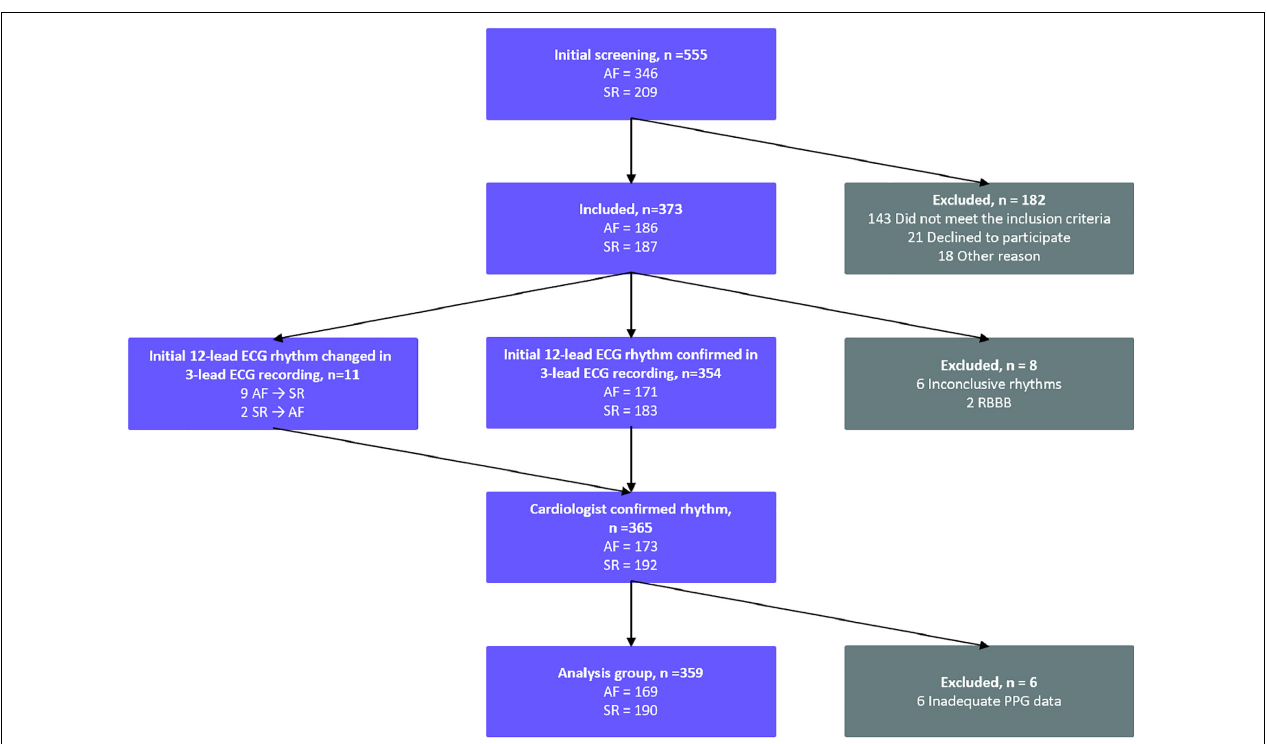
FIGURE 1 | Standards for Reporting Diagnostic Accuracy Studies (STARD) flow diagram of the study patient flow. A total of 555 patients were screened in the participating hospitals KUH, HUS, and NKCH. 359 patients were included in the analysis. AF, atrial fibrillation; ECG, electrocardiogram; SR, sinus rhythm; PPG, photoplethysmography; RBBB, right bundle branch